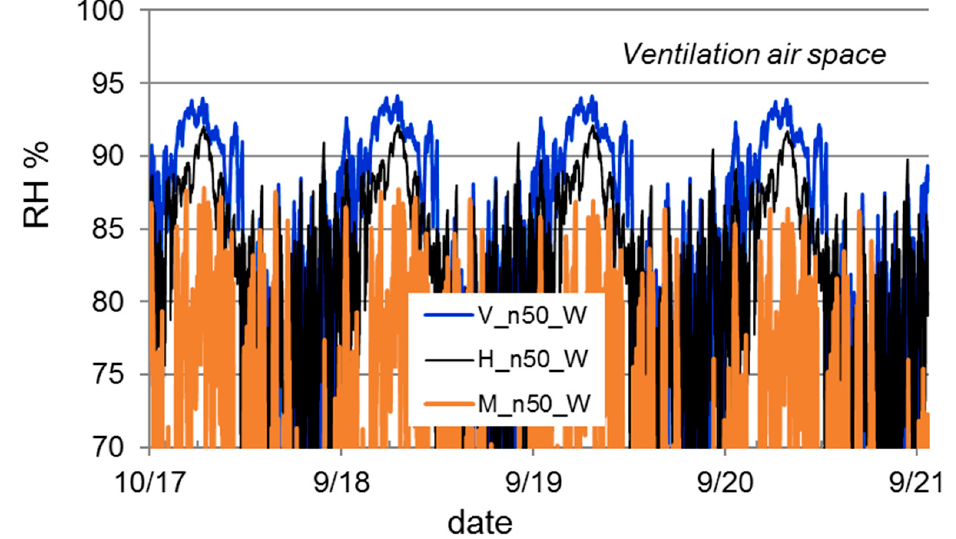
Figure 15. Brick wall, ventilation scheme 1, n = 50 1/h, initially wet exterior core of the old brick wall. The relative humidity in the ventilation air space in three different climates during the four-year simulation period.